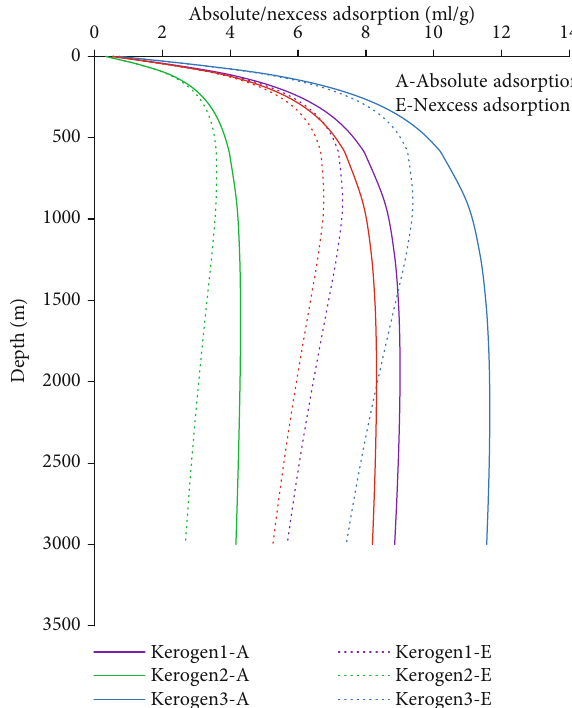
Figure 7: Methane adsorption capacity of kerogen in three samples under geological conditions.